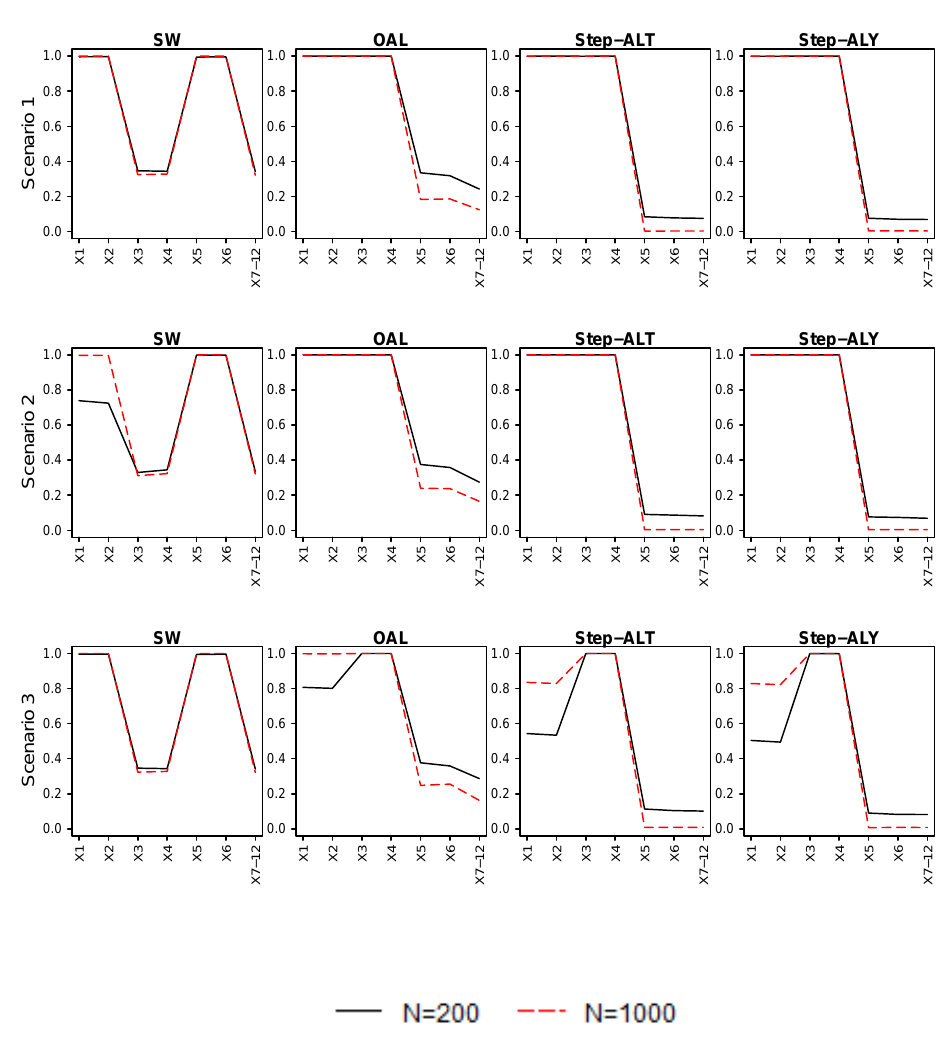
Figure A1. Proportions of each variable selected for propensity model across 500 simulated datasets and 1000 bootstrap samples for each simulated dataset for sample size of 200 and 1000. X 1 and X 2 are the true confounders; X 3 and X 4 are predictors of the outcome but not of the treatment; and X 5 and X 6 are predictors of the treatment but not of the outcome; all the other 14 covariates are spurious. Average across the spurious